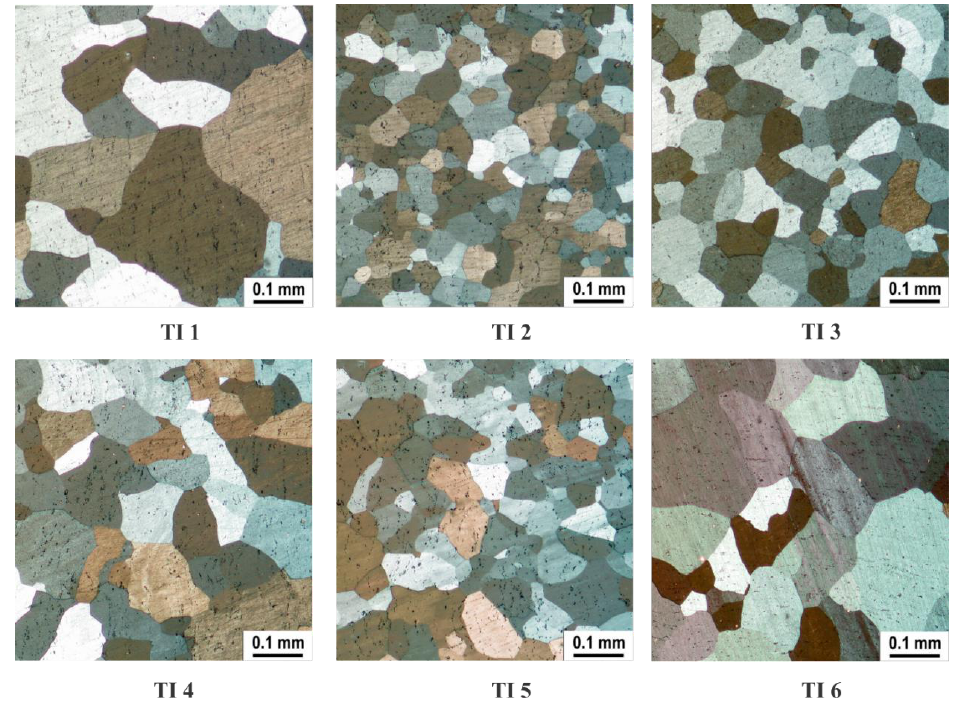
Figure 8. Tested images TI1, TI2, TI3, TI4, TI5 and TI6. Image sizes vary from 724 × 724 (for TI1, TI2 and TI3) to 1536 × 1536 (for TI4, TI5 and TI6).